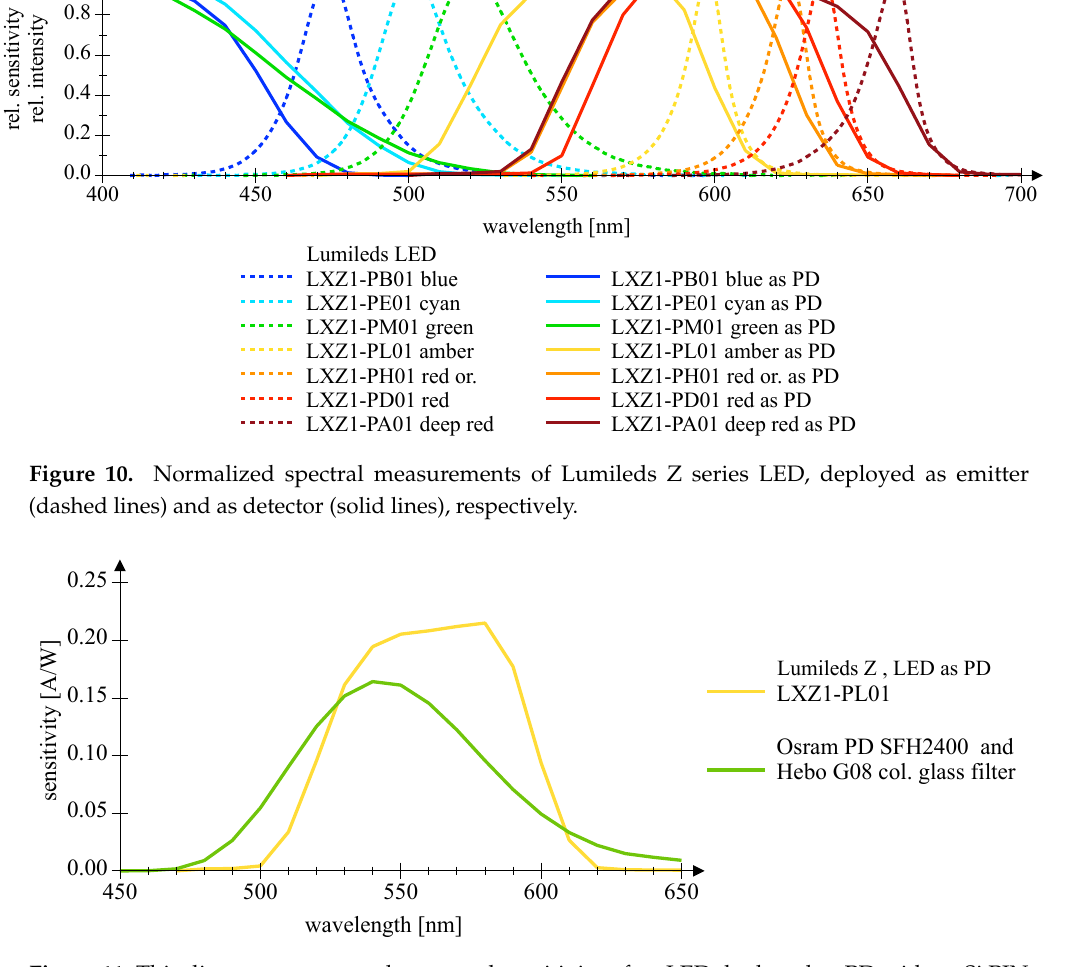
Figure 11. This diagram compares the spectral sensitivity of an LED deployed as PD with an Si PIN photodetector combined with a colored glass bandpass filter